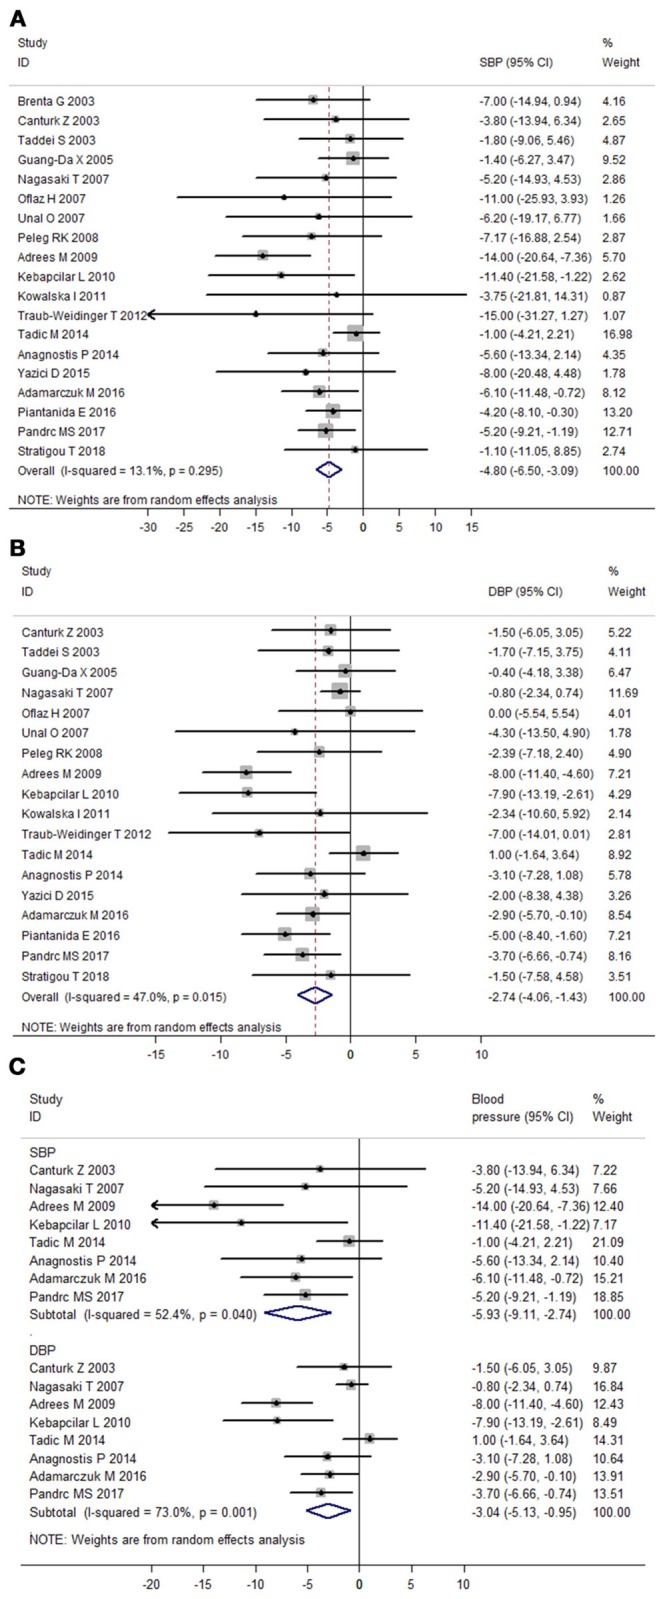
Meta-analysis of prospective follow-up studies assessing the effect of LT4 therapy on blood pressure in SCH patients. (A) Effect of LT4 therapy on SBP in SCH patients. (B) Effect of LT4 therapy on DBP in SCH patients. (C) Meta-analysis of eight prospective follow-up studies with good quality.